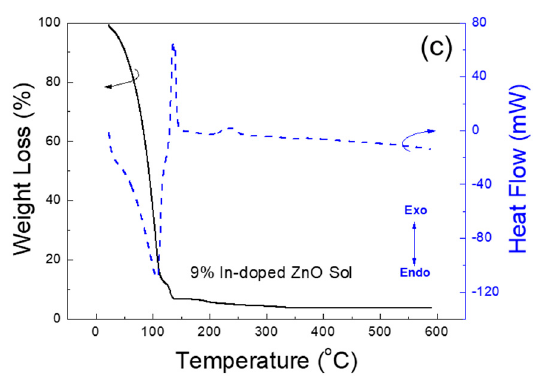
Figure 2. TGA-DSC curves of the ( a ) ZnO; ( b ) In 2 O 3 and ( c ) 9% In-doped ZnO sols, respectively.